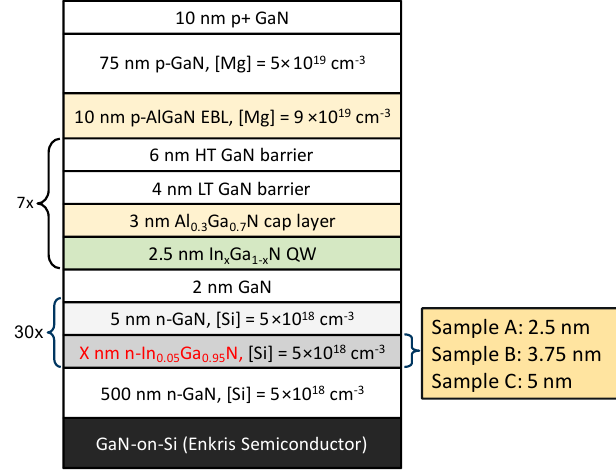
Figure 1. Epitaxial structure for GaN-on-Si red LEDs.